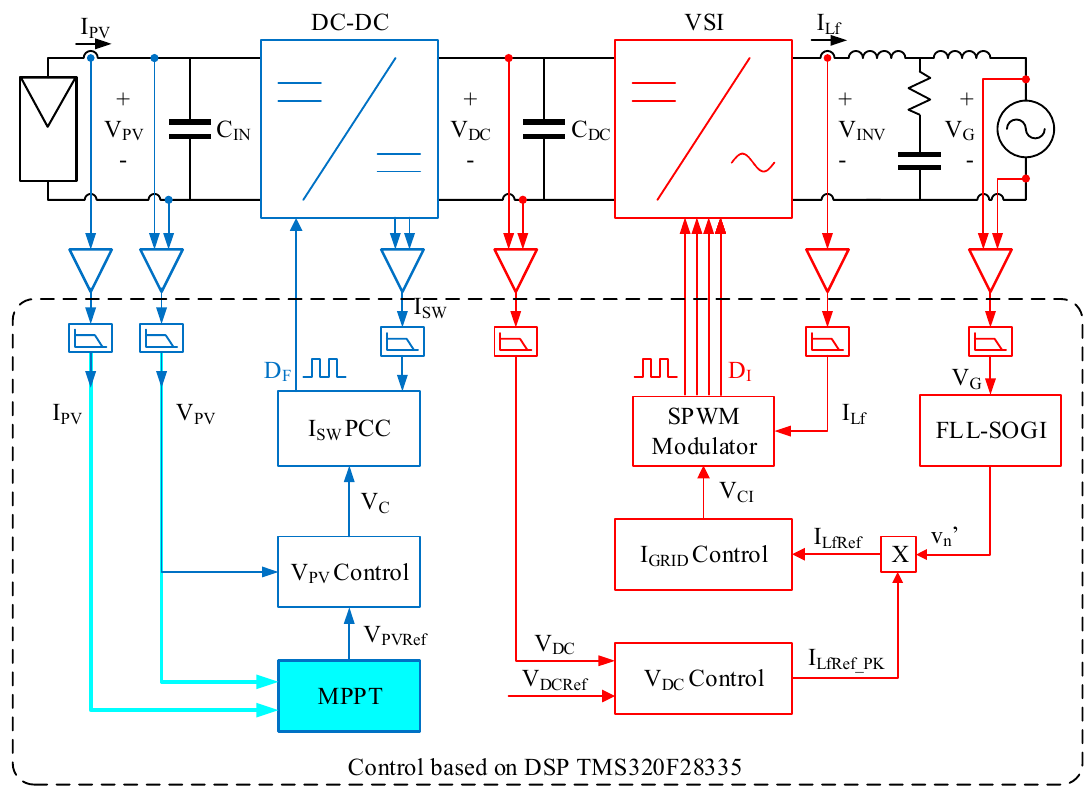
Figure 9. Conventional MPPT implementation.